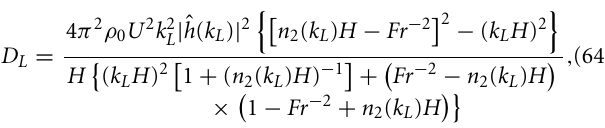
function of Fr for l 2 H = 0 . 5 and l 2 a = 1. Solid line: total drag, dotted line: internal gravity wave drag, dashed line: trapped lee wave drag, all from theory; symbols: numerical simulations. Reproduced from Figure 9 of Teixeira et al. [112]. © American Meteorological Society. Used with